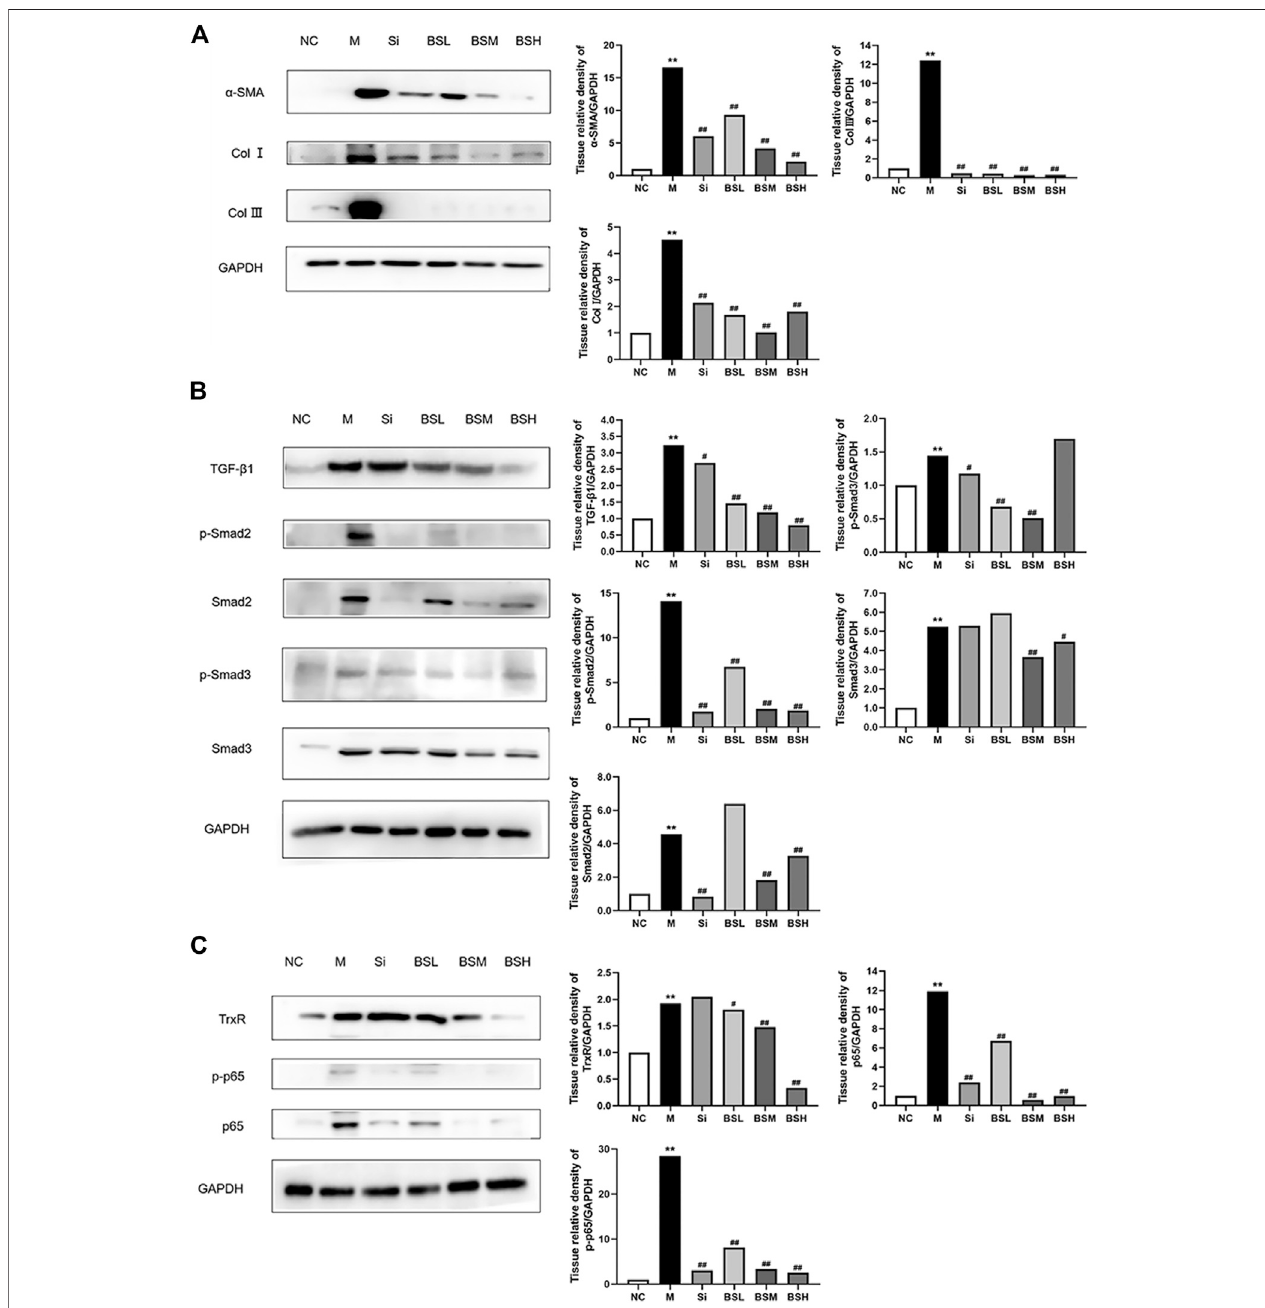
FIGURE6| BSinhibitedtheexpressionsof fi brosis-relatedproteins invivo . (A) Theprotein levelsof α -SMA,ColI,and ColIIIasmeasuredbyWestern blotanalysis. (B) The protein expressions of TGF- β 1, p-Smad2, Smad2, p-Smad3, and Smad3 as measured by Western blot analysis. (C) The protein expressions of TrxR, NF- κ B p-p65, and p65 as measured by Western blot analysis. Data were shown as mean ± SD, n ≥ 3 and analyzed with the one-way ANOVA. ** p < 0.01 in the model group versus the control group. # p < 0.05, ## p < 0.01, Si, BSL, BSM, and BSH groups versus the model group.